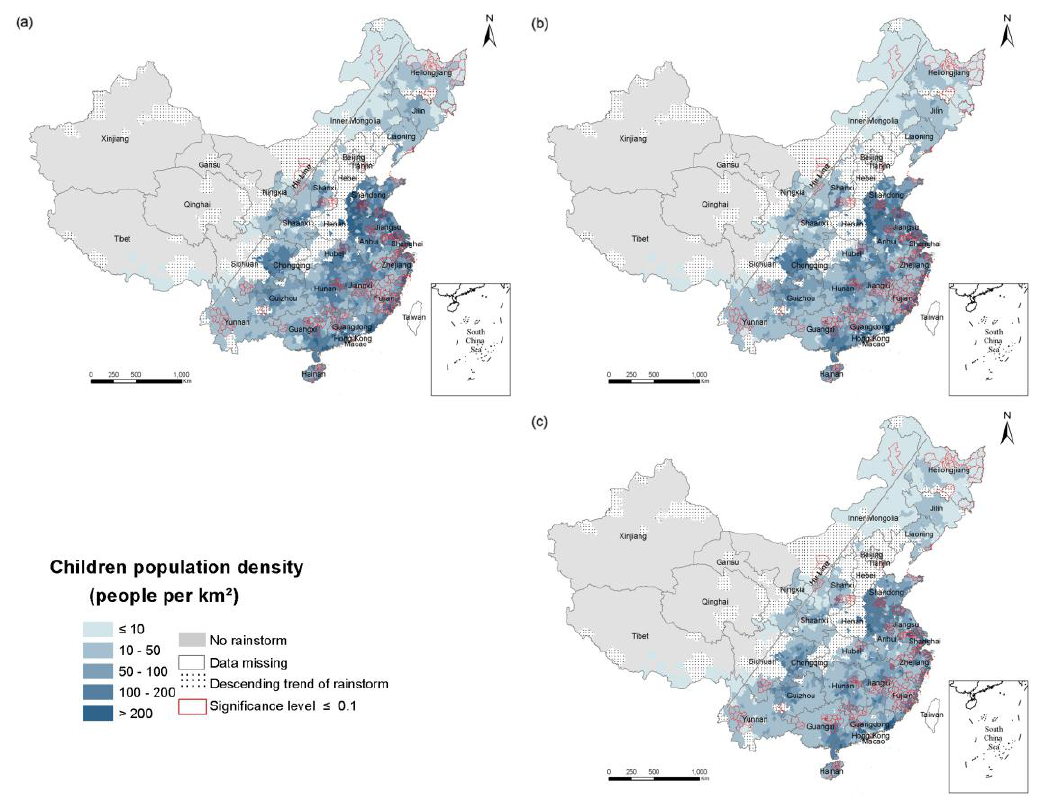
Figure 5. The density of child population in the RSHA. ( a ) 1990; ( b ) 2000; ( c ) 2010.